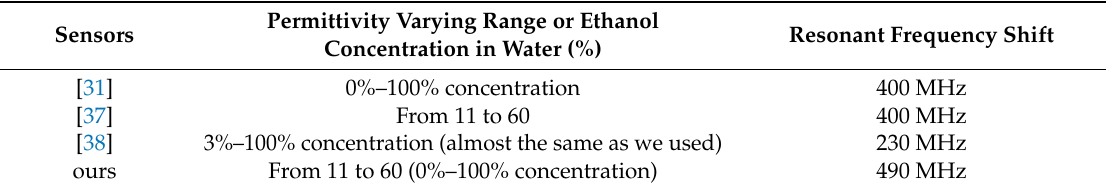
Table 3. Comparison of sensitivity between our sensor and other microwave sensors.